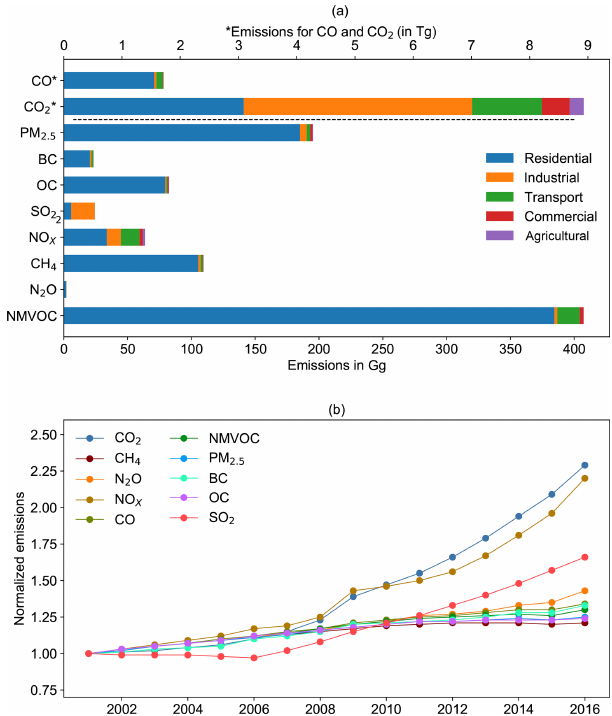
Figure 5. National emission estimates for aerosols and trace gases for (a) each sector in 2011 and (b) normalized trends for the period